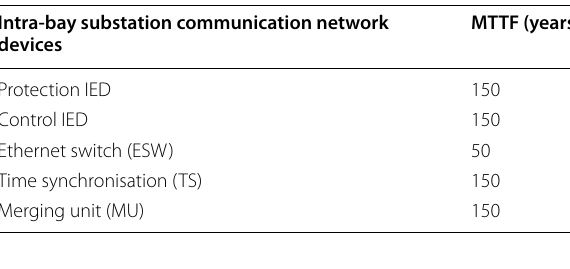
Table 1 MTTF data of substation devices [36]